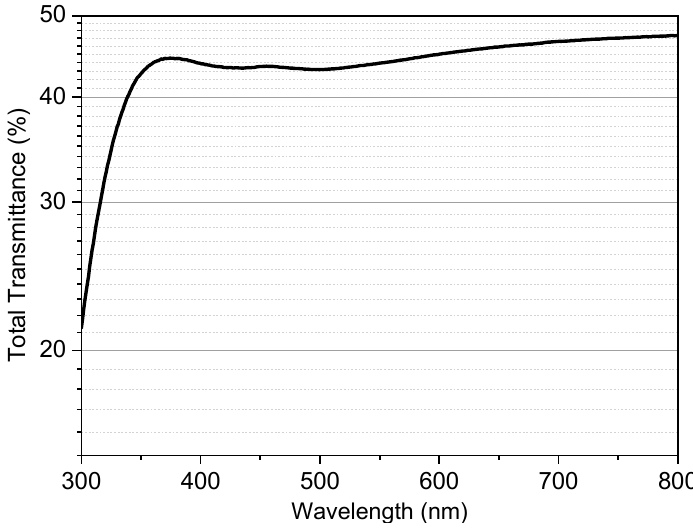
Figure 6. Total transmittance spectrum of a ‘tile’ from the overlapping of 4 layers (800 μ m).